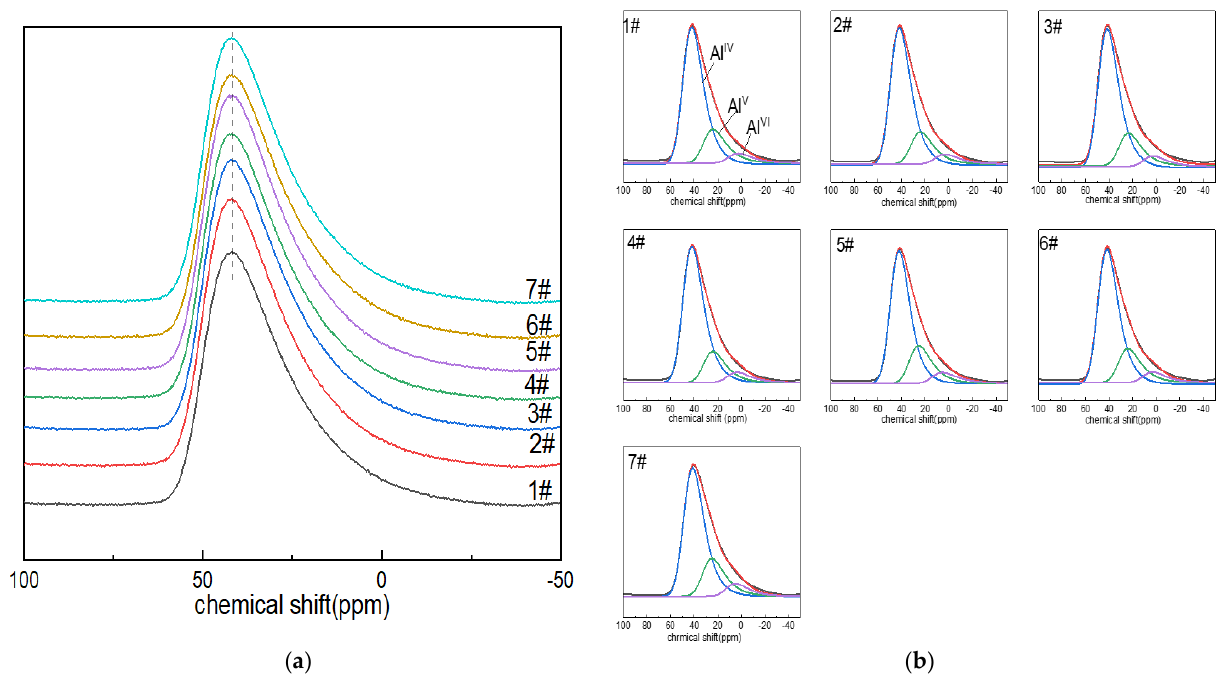
Figure 1. ( a ) 27 Al MAS NMR images of Li 2 O − Al 2 O 3 − SiO 2 glass with different B 2 O 3 contents; ( b ) fitting diagram of 27 Al MAS NMR peaks of Li 2 O − Al 2 O 3 − SiO 2 glass with different B 2 O 3 contents. Table 2. Calculation results of GIM model fitting of 27 Al NMR spectra.